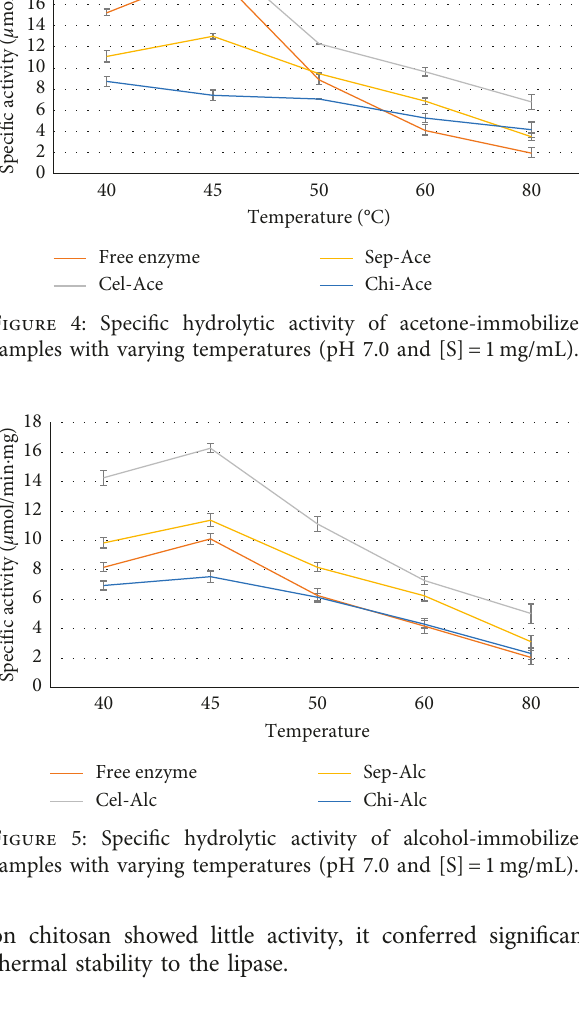
samples with varying pH values (temperature 45 ° C and [S] 1mg/mL).